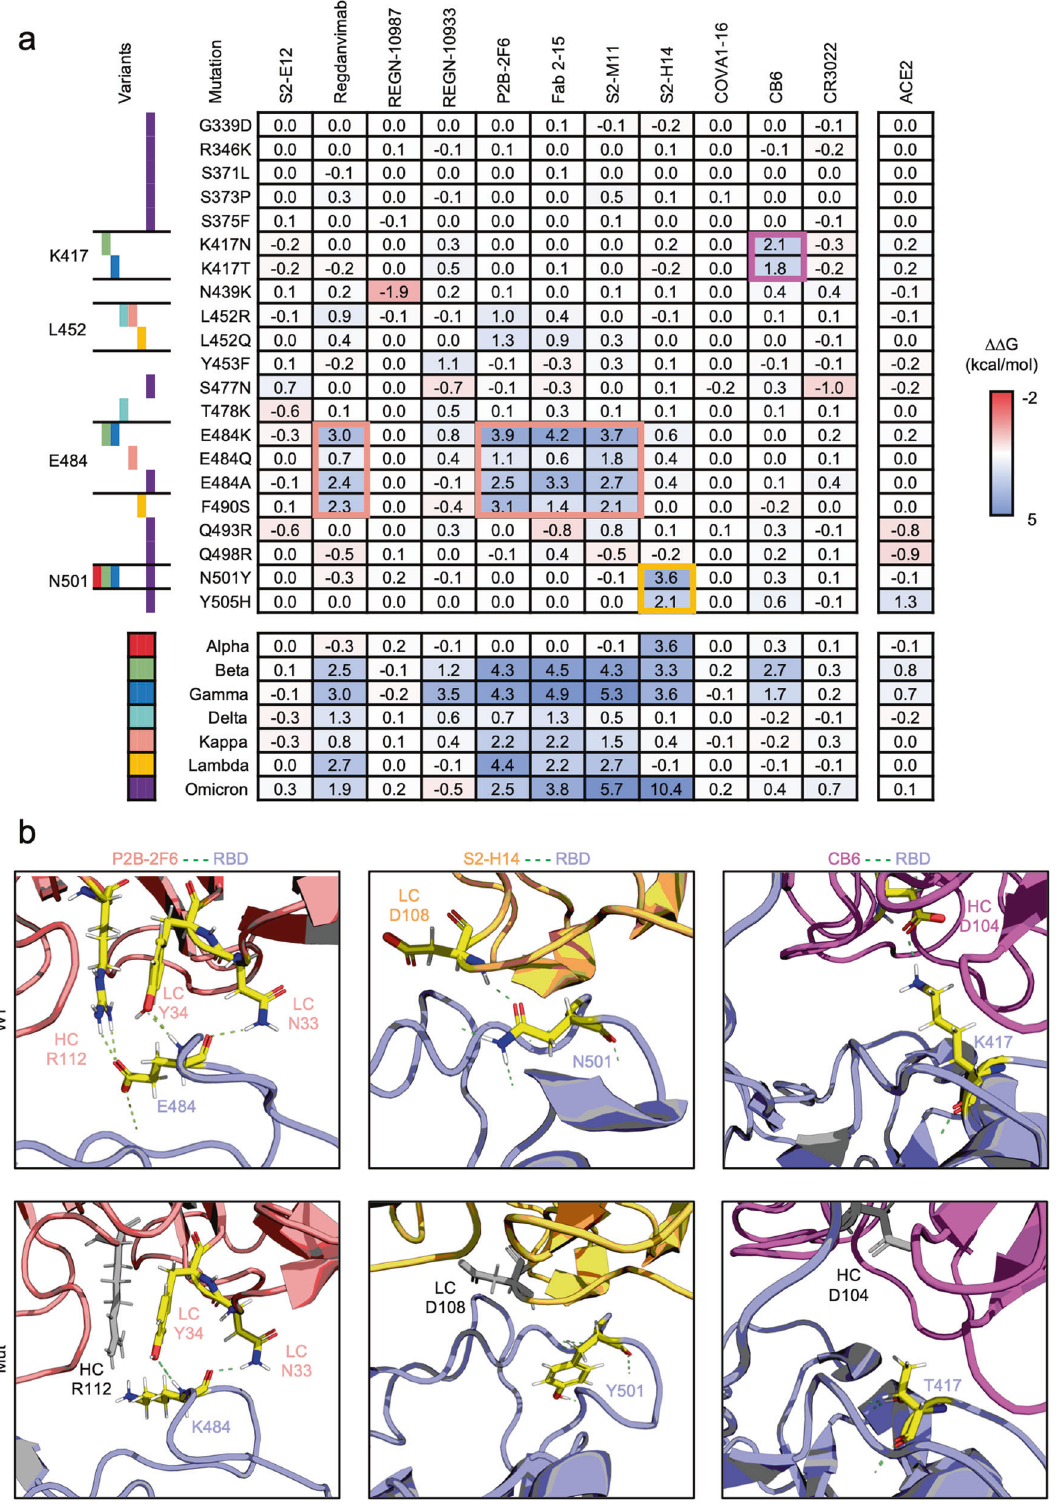
Signal Transduction and Targeted Therapy (2022)